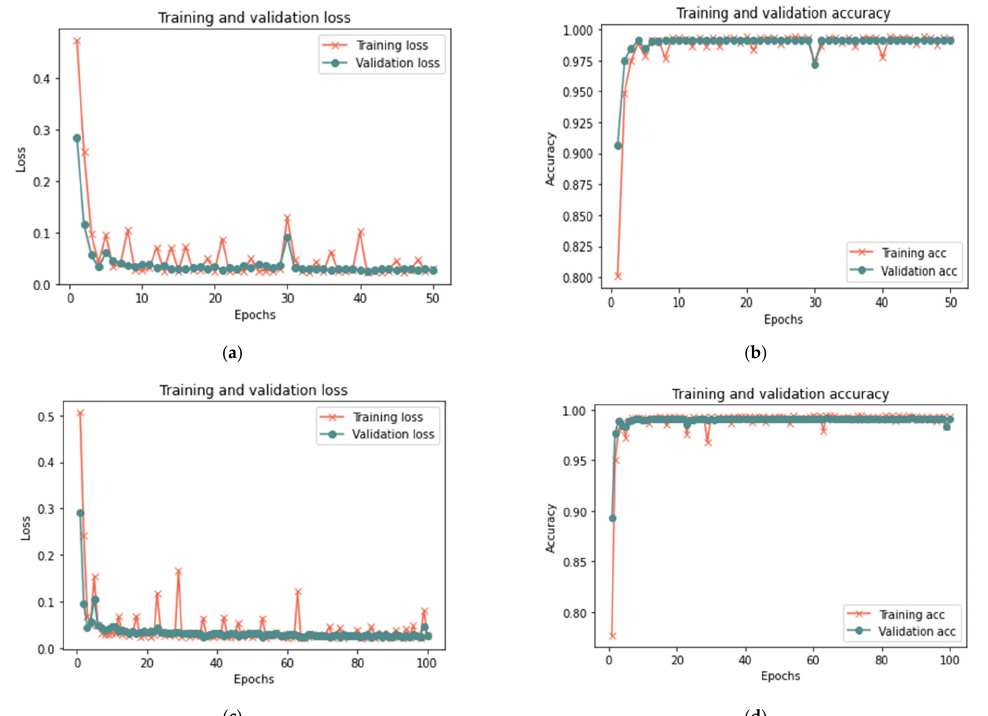
Figure 14. Results of the second scenario with 50% sample size: ( a ) loss at 50 iterations; ( b ) accuracy at 50 iterations; ( c ) loss at 100 iterations; and ( d ) accuracy at 100 iterations.